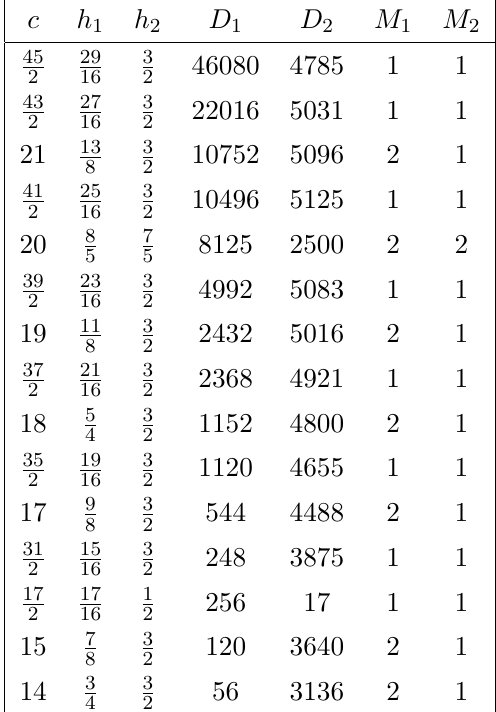
Table 1 . Degeneracies for 3-character coset theories.